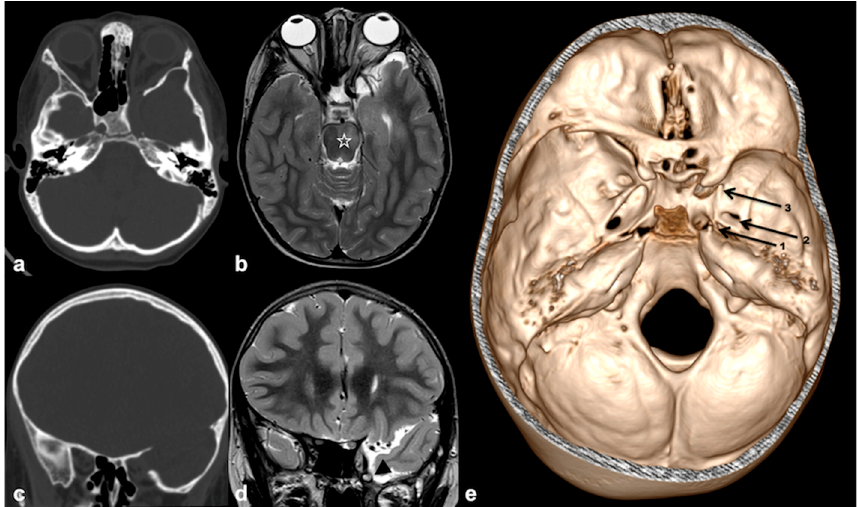
Figure 7. Axial CT ( a ) and TSE T2w MRI ( b ), and coronal CT ( c ) and TSE T2w MRI ( d ) of a 6 years-old boy with NF1, showing left sphenoid wing dysplasia with enlargement of the left orbit (bare orbit sign), bony defect of the posterior orbital wall and enlargement of middle cranial fossa (with associated meningocele—black arrowhead). Brainstem FASIs are also visible on axial TSE T2w MRI (white star). CT volume rendering ( e ) confirmed middle cranial fossa asymmetry with reduced foramina diameter on the affected side (black arrows: 1-carotid canal; 2-foramen ovale; 3-foramen rotundum).